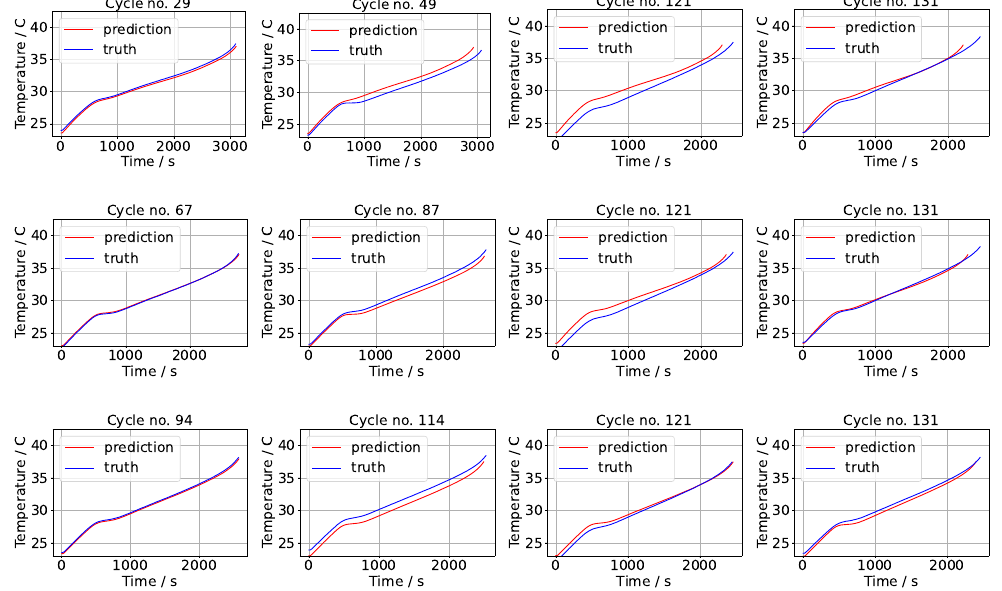
Figure 6. Temperature results for the data set B0018 for different numbers of training points. From the top row to the bottom row, 20%, 50% and 70% of the data is